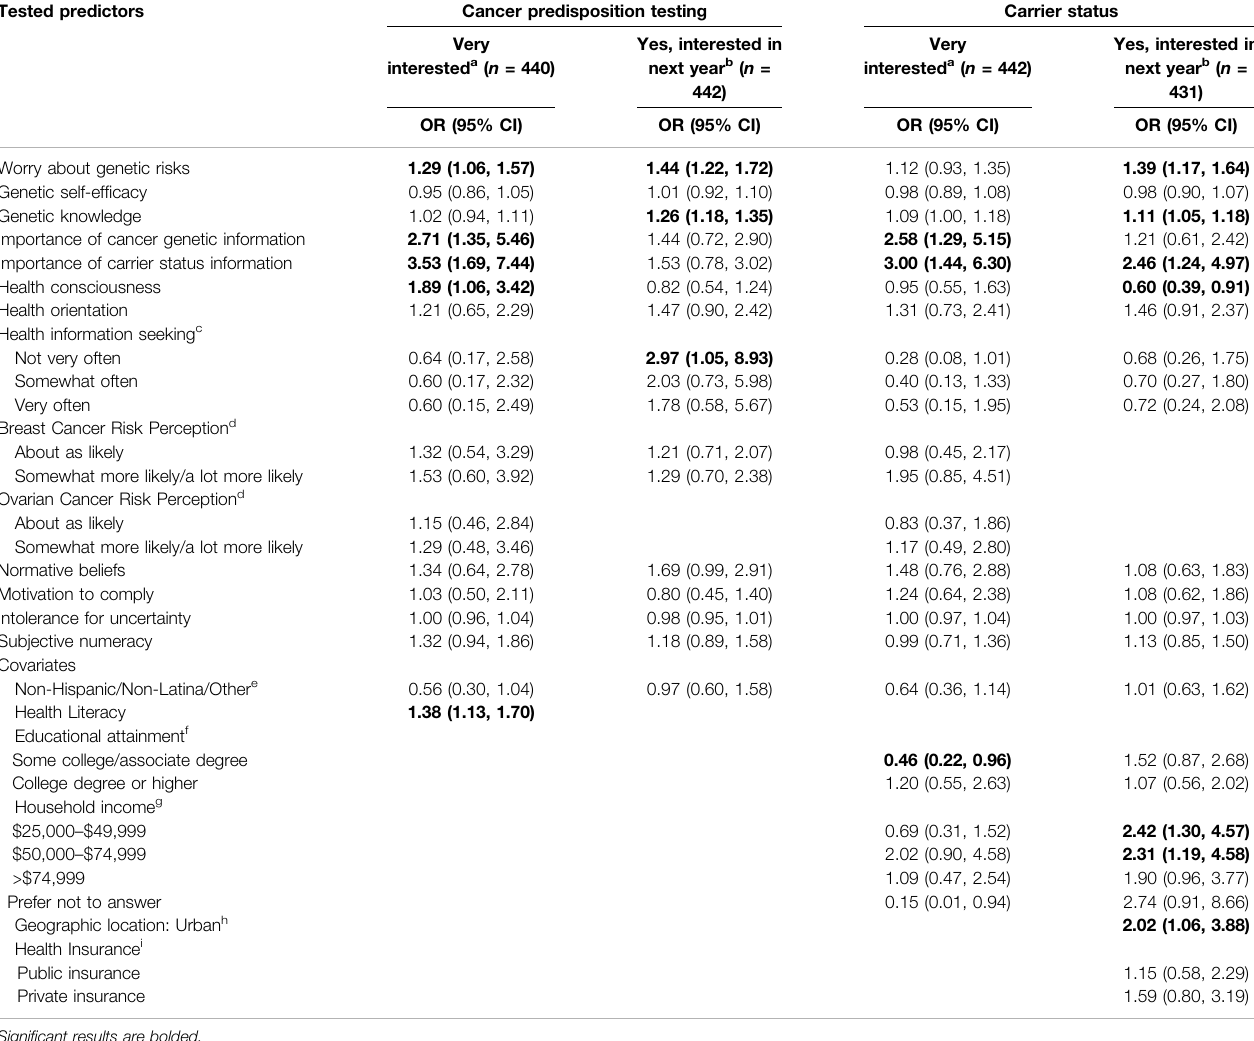
TABLE 6 | Multivariable logistic regression models showing predictors of interest in receiving cancer predisposition testing and carrier screening. Tested